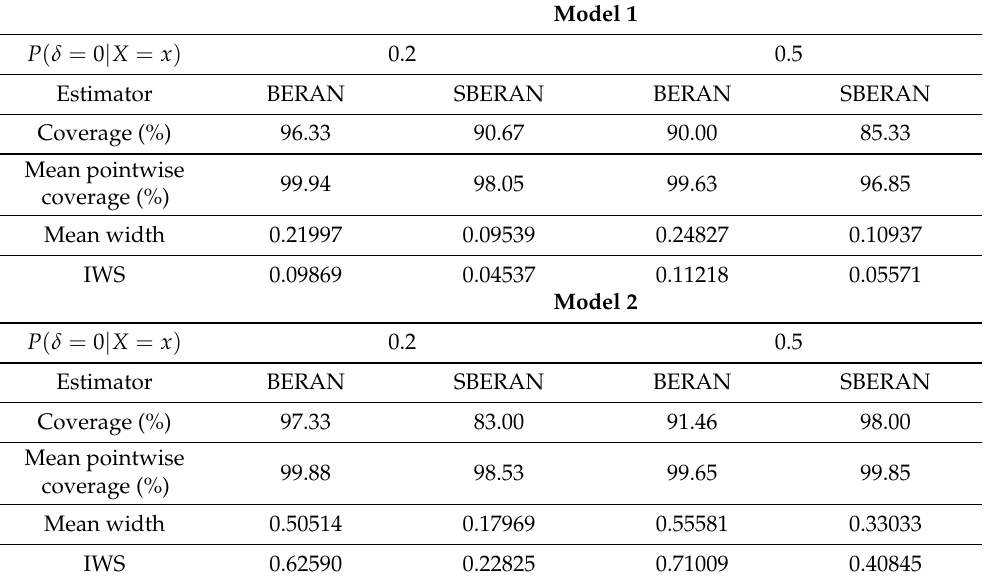
Table 5. Coverage, average width and IWS of the 95% confidence regions by means of Beran’s and the smoothed Beran’s estimators using N = 300 simulated samples from Models 1 and